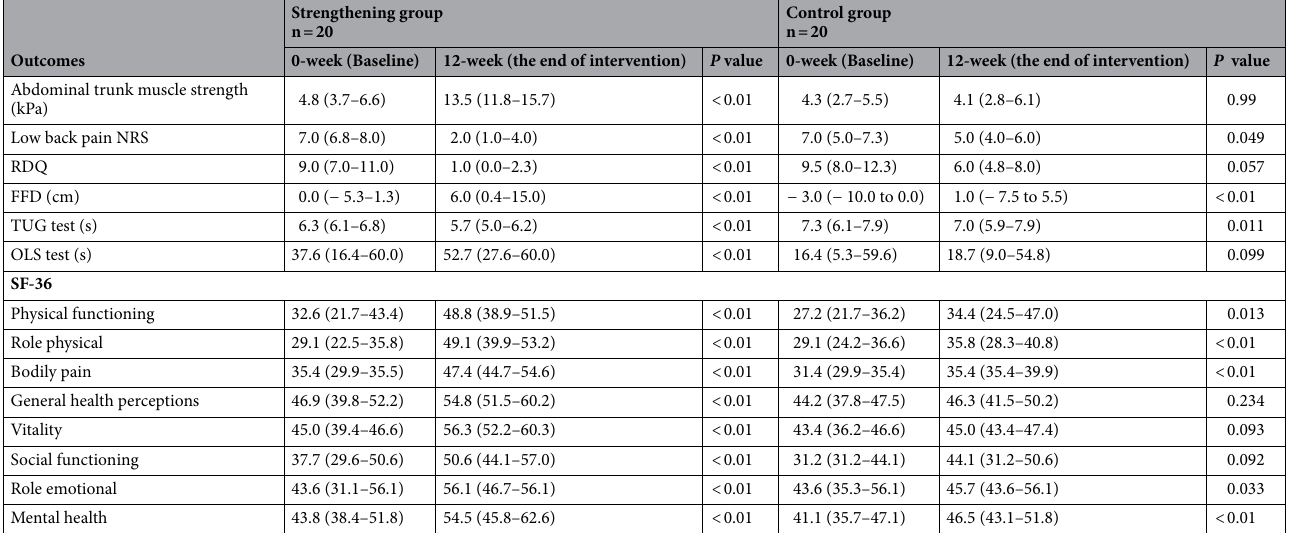
Table 2. Outcomes at baseline and after the 12-week intervention of both groups. Data are presented as the median and interquartile range. NRS numerical rating scale, RDQ The Roland Morris Disability Questionnaire, FFD Finger-floor distance, TUG Timed up and go, OLS one-leg standing, SF‑36 Short-Form 36-Item.